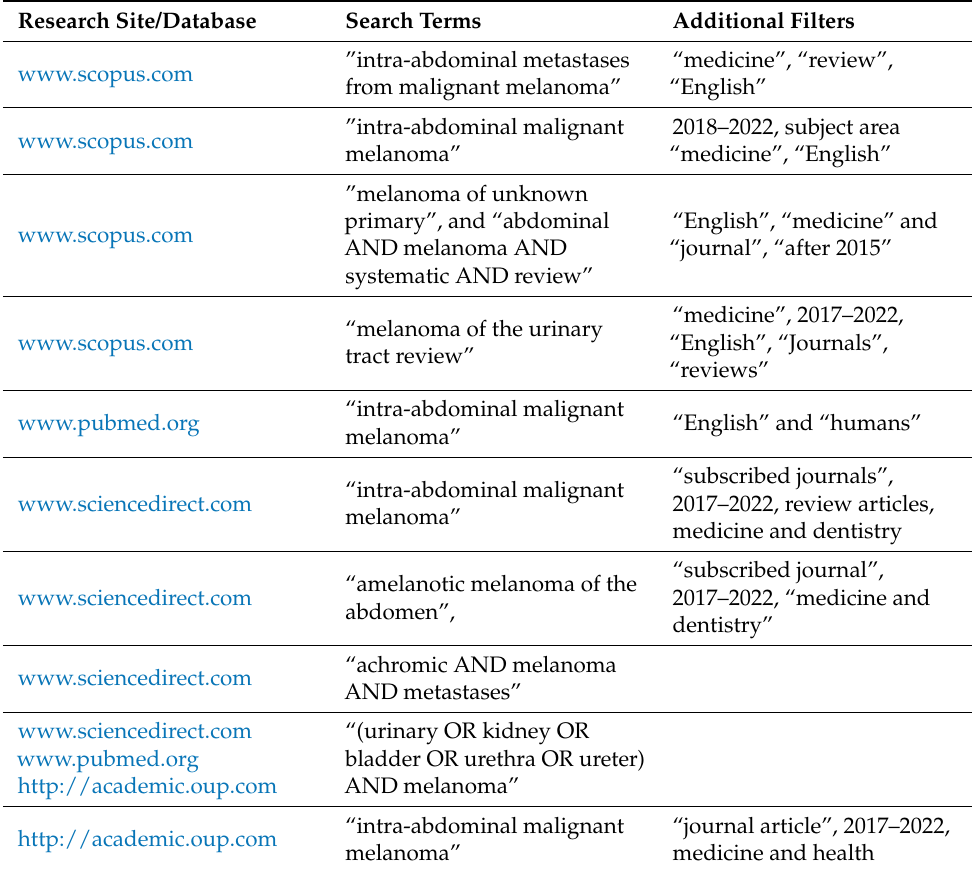
Table 1. Databases, search terms, and filters used in documenting the present literature review on intra-abdominal malignant melanoma, accessed between 3 May 2022 and 3 June